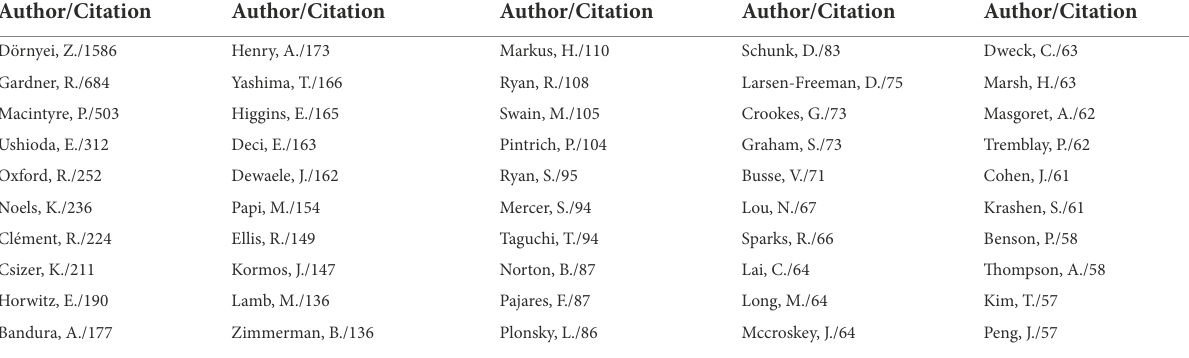
TABLE 2 Citation of the top 50 most-cited authors between 2000 and